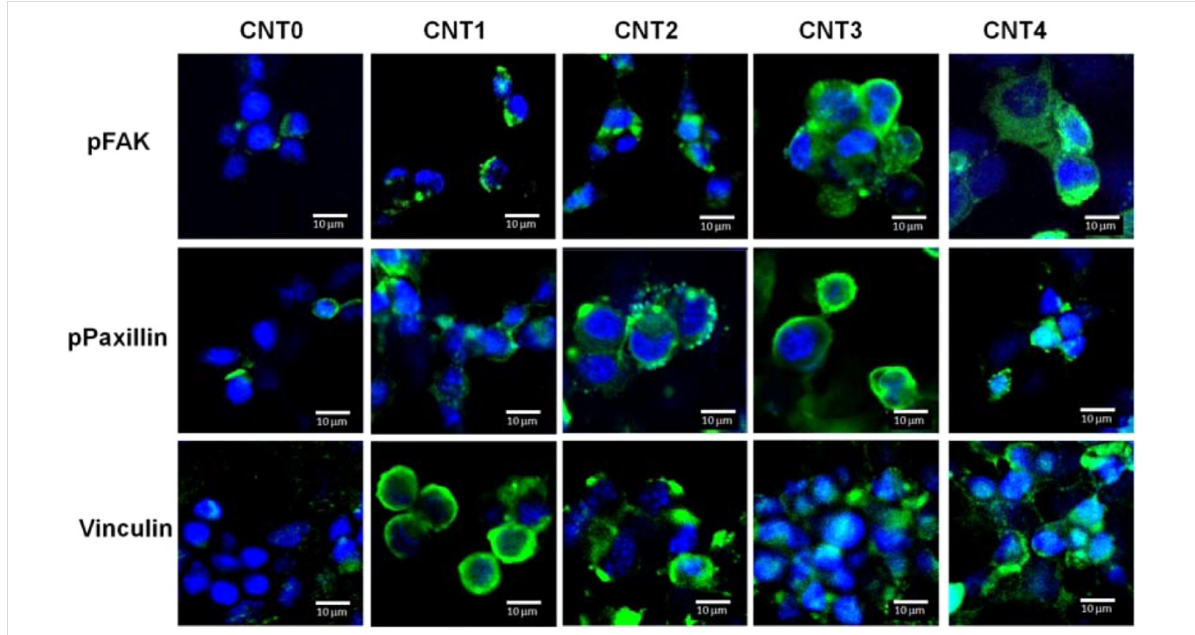
Figure 5: Adhesive molecules possibly involved in the initial cell adhesion events, analysed by immunostaining images. Signals positive for p-FAK, p-paxillin, and vinculin were strongly expressed in all the CNT–chitosan hybrid coatings but not in CNT0. Figure 5 was reprinted with permission from [59], Copyright 2014 American Chemical Society. This content is not subject to CC BY